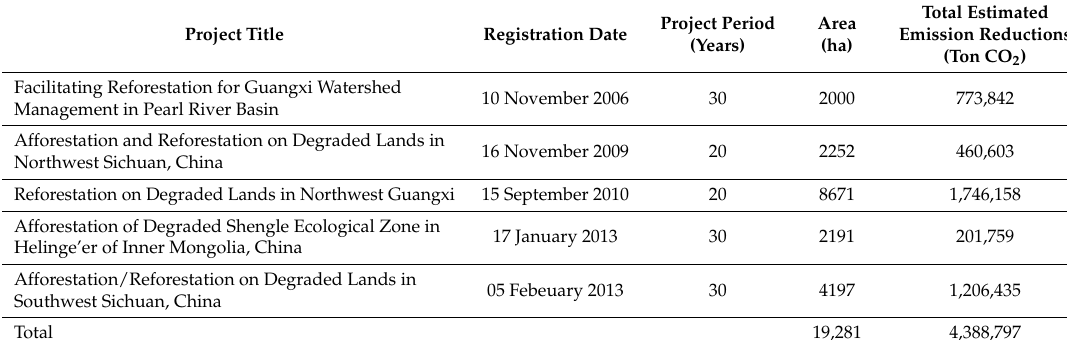
Table 1. Registered CDM afforestation and reforestation projects from China